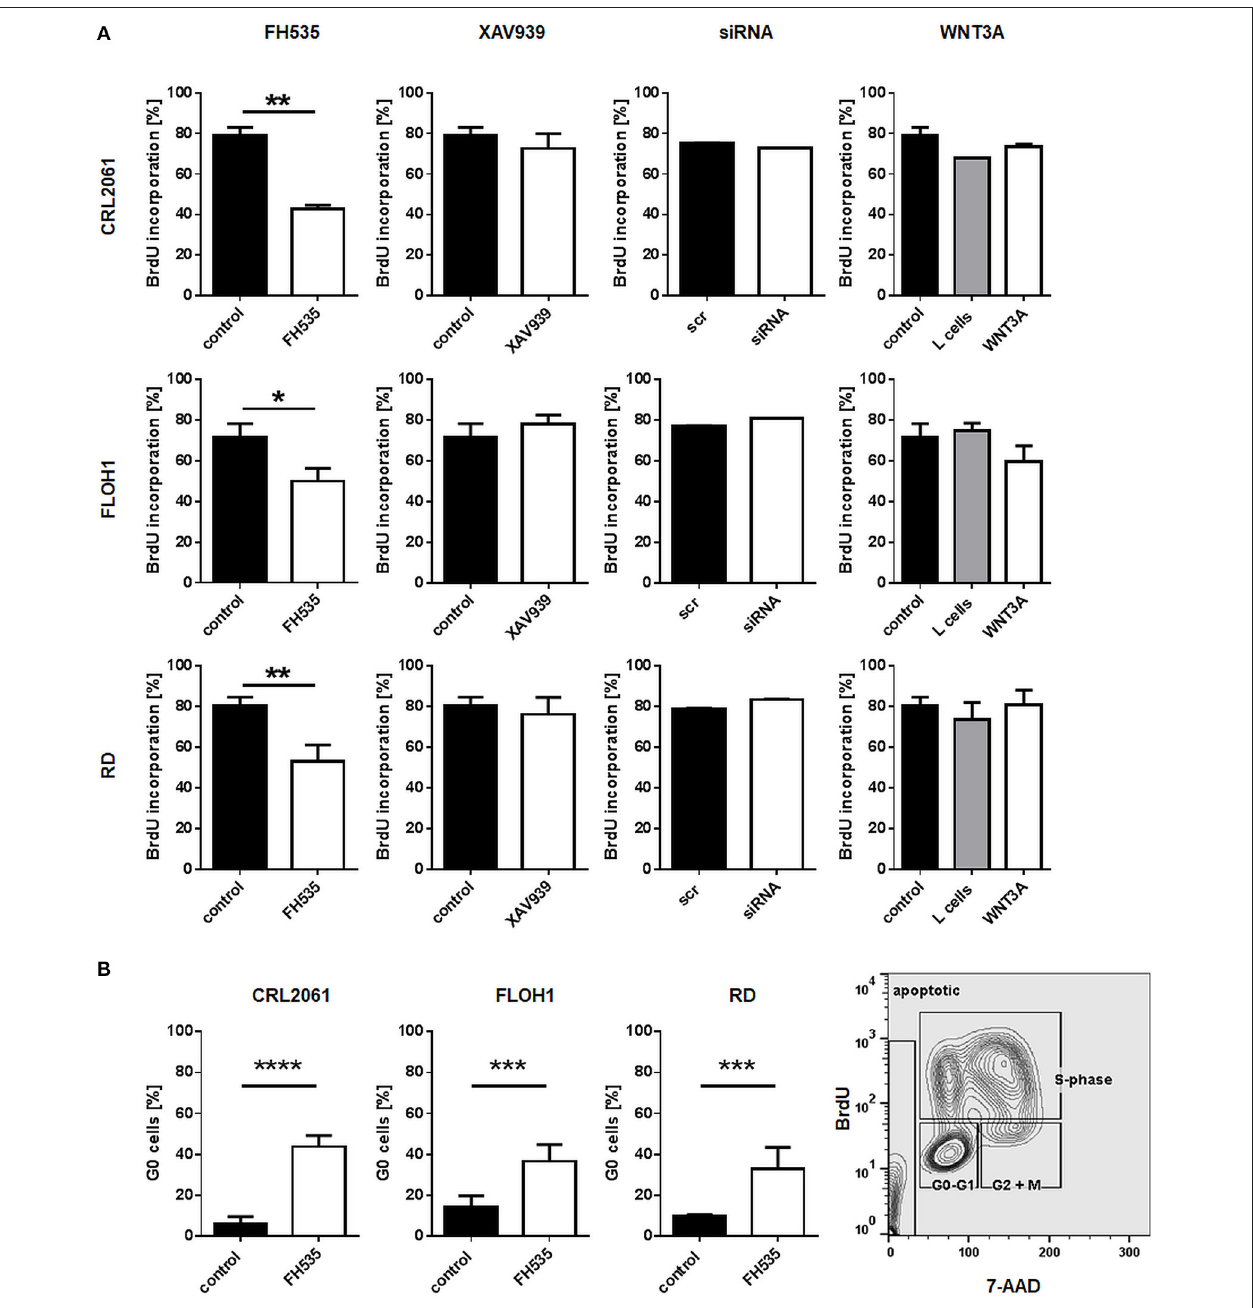
FIGURE 4 | Effects of FH535, XAV939, ß-catenin siRNA, or WNT3A on proliferation of RMS cell lines. (A) Incorporation of BrdU after treatment of RMS tumor cells with FH535, XAV939, a ß-catenin-specific siRNA, or WNT3A conditioned medium. The mean percentage and SEM of BrdU positive cells out of three independent experiments are shown. (B) . Analysis of G0 cells with and without FH535 treatment. The bars represent mean percentage and SEM of G0 cells of three independent experiments. Right graph shows the gating strategy on the basis of FH535 treated RD cells. Significance level: * p < 0.05, ** p < 0.01, *** p < 0.001, **** p <